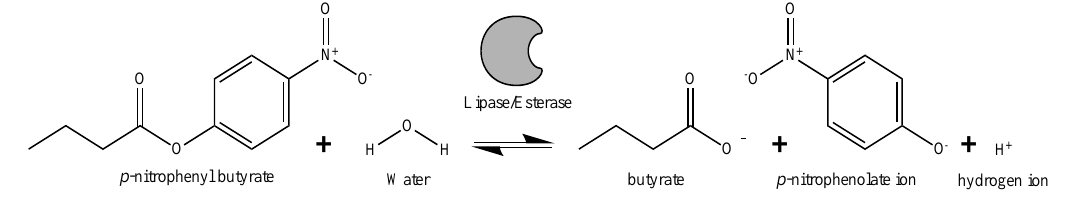
Figure 1. Enzymatic hydrolysis reaction of p -nitrophenyl